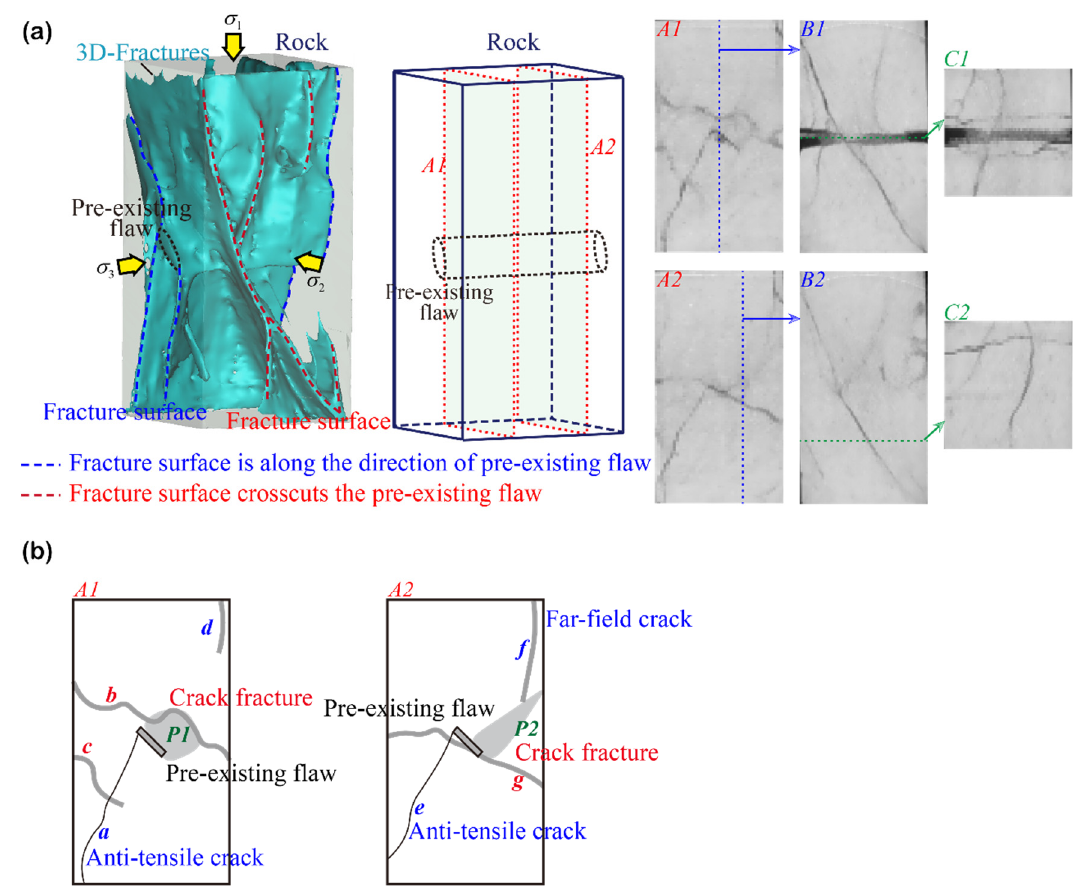
Figure 10. ( a ) Distribution of internal fissures in rocks with prefabricated fissures under the TTT-c3 condition; ( b ) Various crack types from a single fissure identified.